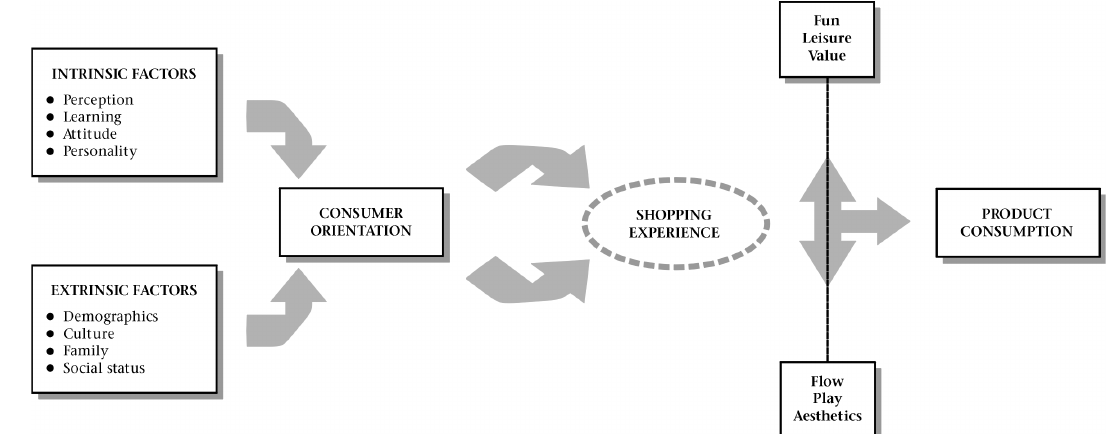
Figure 1: Possible outcomes of the shopping experience independent of product